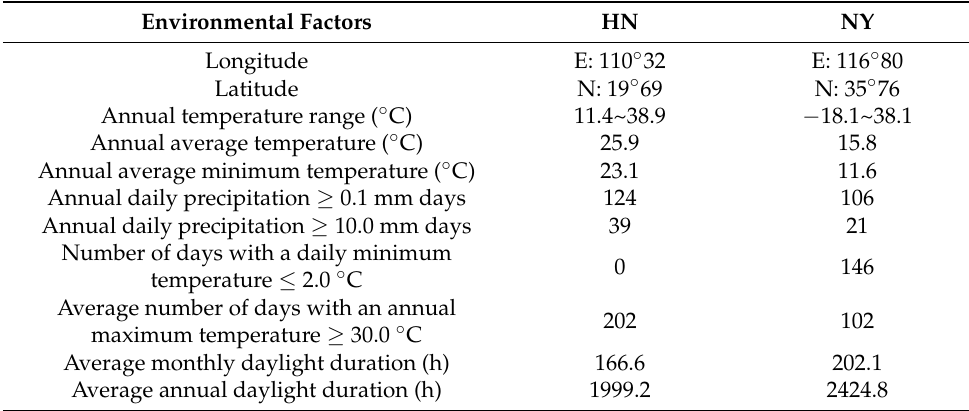
Table 1. Test site environmental conditions. Ningyang (NY) has a temperate monsoon climate, and Hainan (HN) has a tropical monsoon climate. Shown are the average climate data for the past two